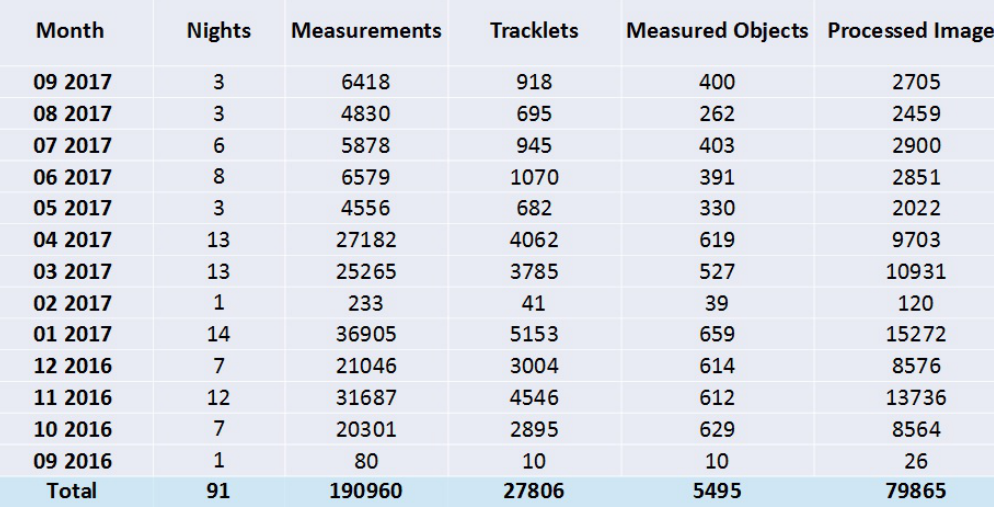
Figure 9. Statistics of ORI-25 optical measurements at Monterrey, September 2016–September 2017.